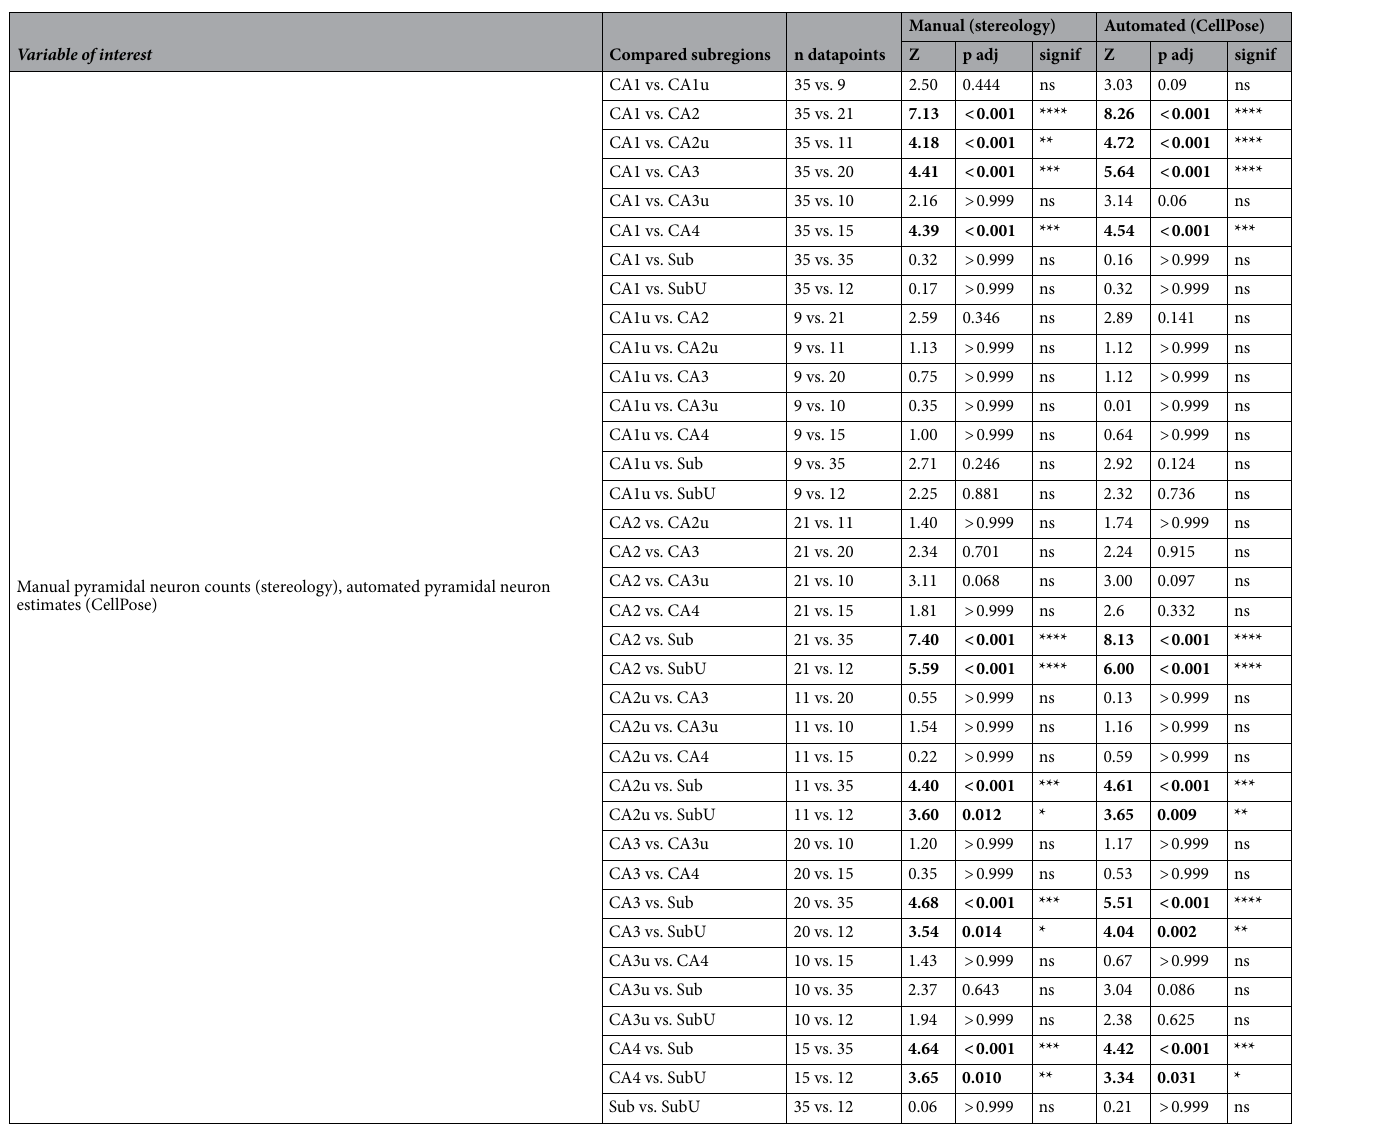
Table 3. Direct comparison of hippocampal subregion pyramidal layer neuron counts. Compared subregions, number of subregions (n datapoints), as well as for both methods (automated CellPose versus manual stereology) q-statistic, adjusted p-value and significance. Computed using Kruskal–Wallis H-tests and corrected for multiple comparisons using Dunn’s tests. Significant differences are shown in bold. *p <